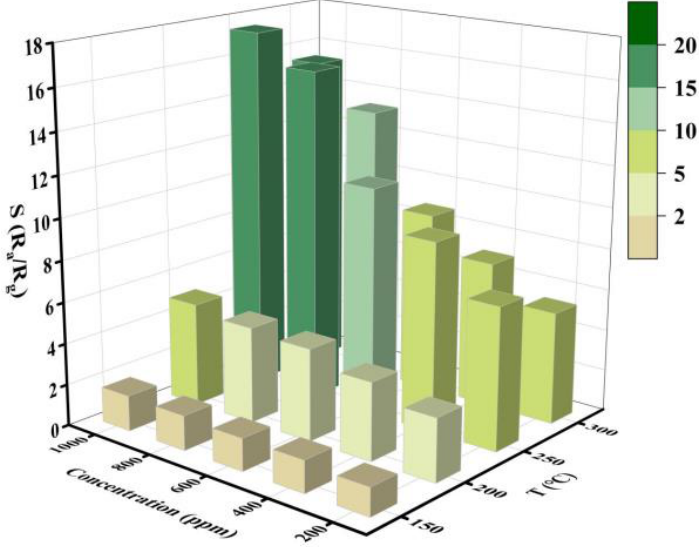
Figure 7. Gas-sensing response of Sn/SnO 2 sample to different ethanol concentrations at different operating temperatures.